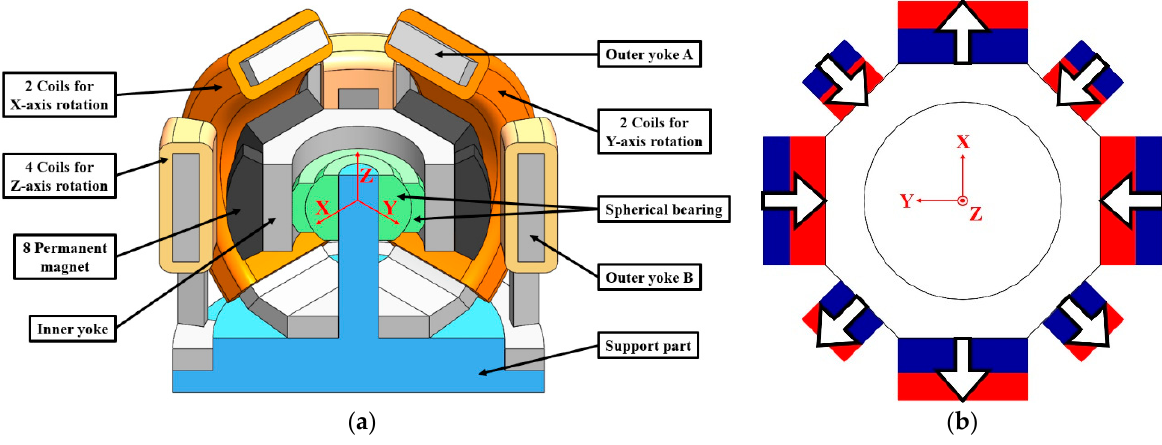
Figure 2. ( a ) Detailed components and ( b ) magnetization of permanent magnets in original 3-DOF spherical motor.